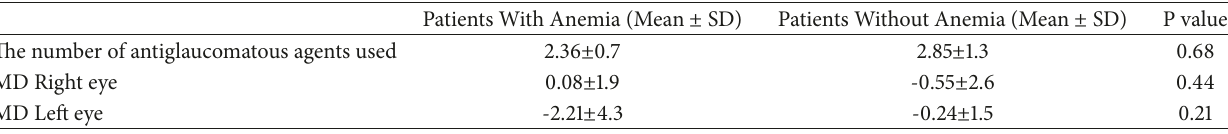
Table 2: Comparisonofthenumber of antiglaucomatous agents used and changes of visual fields patients in glaucoma patients according to presence of